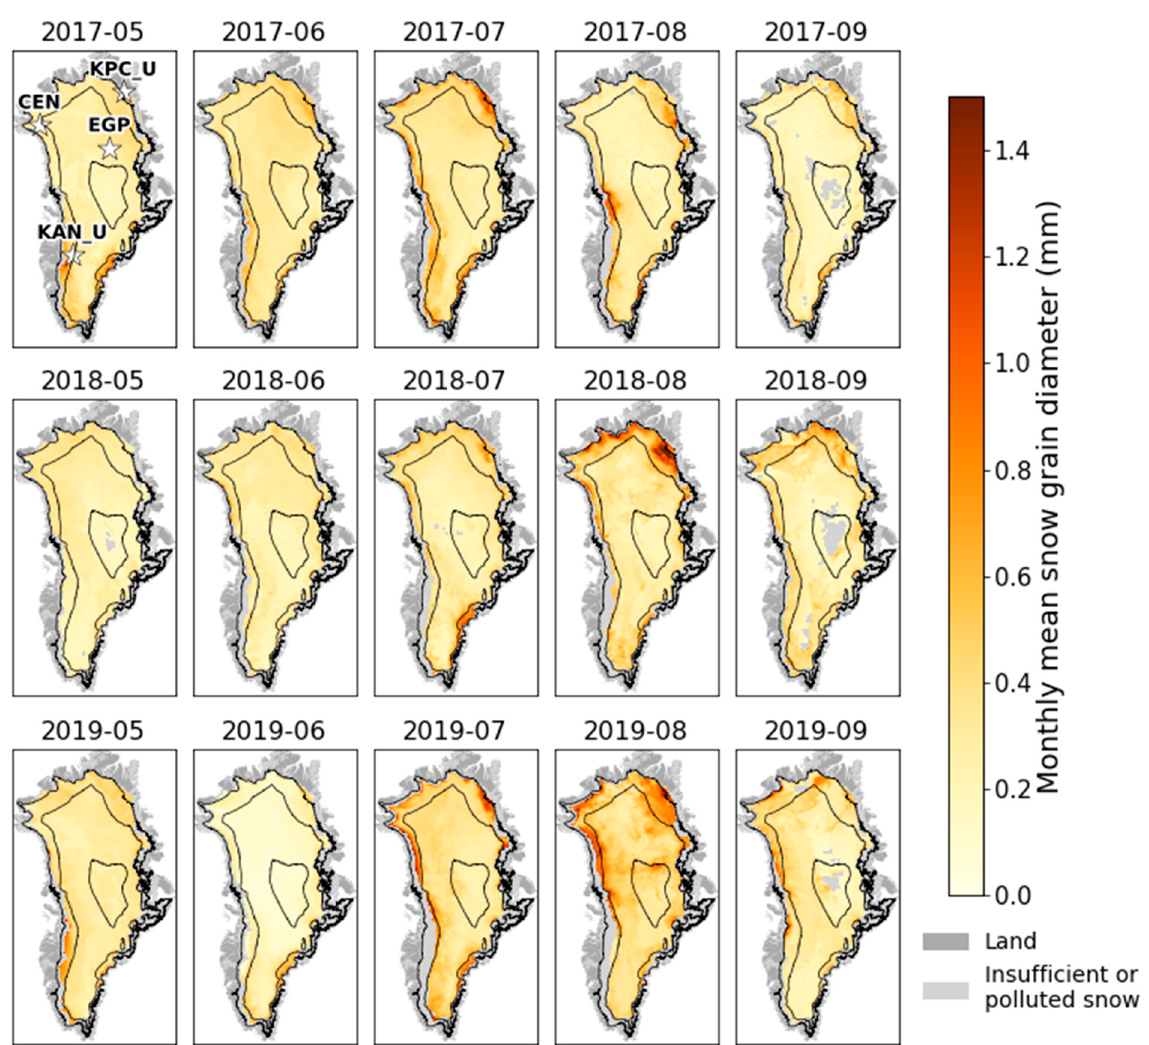
Figure 3. Monthly average of retrieved snow optical grain diameter ( d opt ). Black lines indicate 1000 m elevation contours [89].